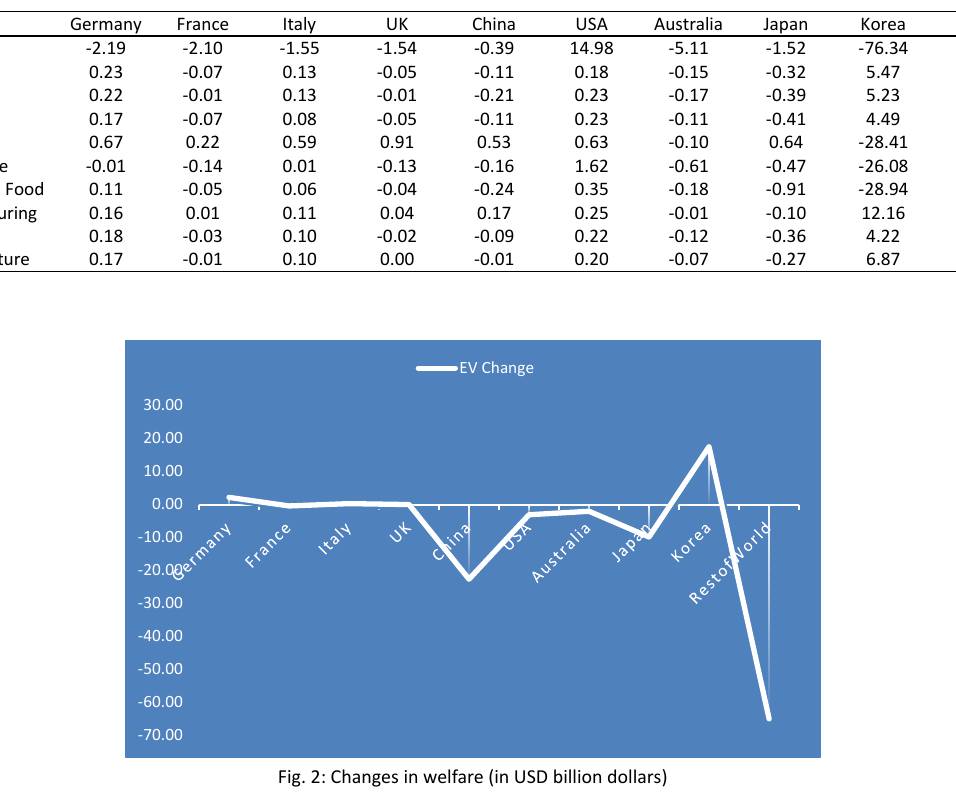
Table 7: Change in market price by sector (%)